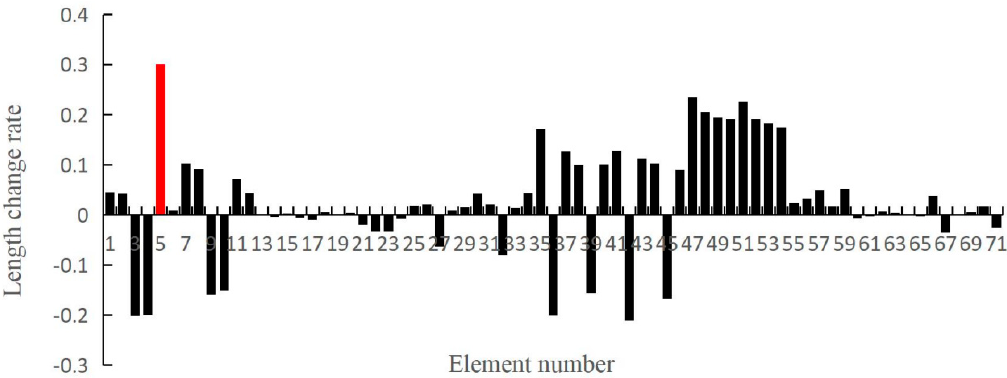
Figure 10. Length change rate of element obtained from the dynamic data (element 5 was damaged adding 5% noise).